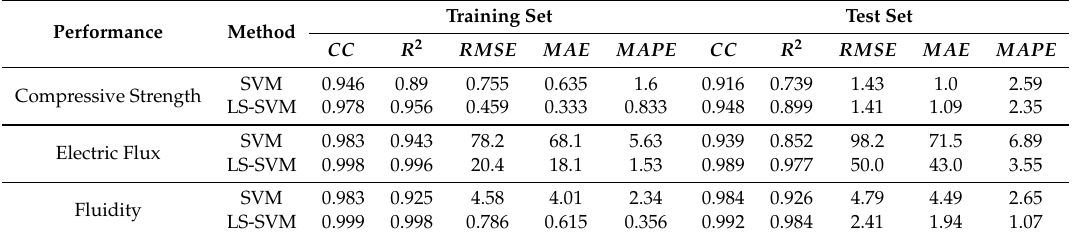
Table 7. Error measurements for predicting performance based on the SVM and LS-SVM.